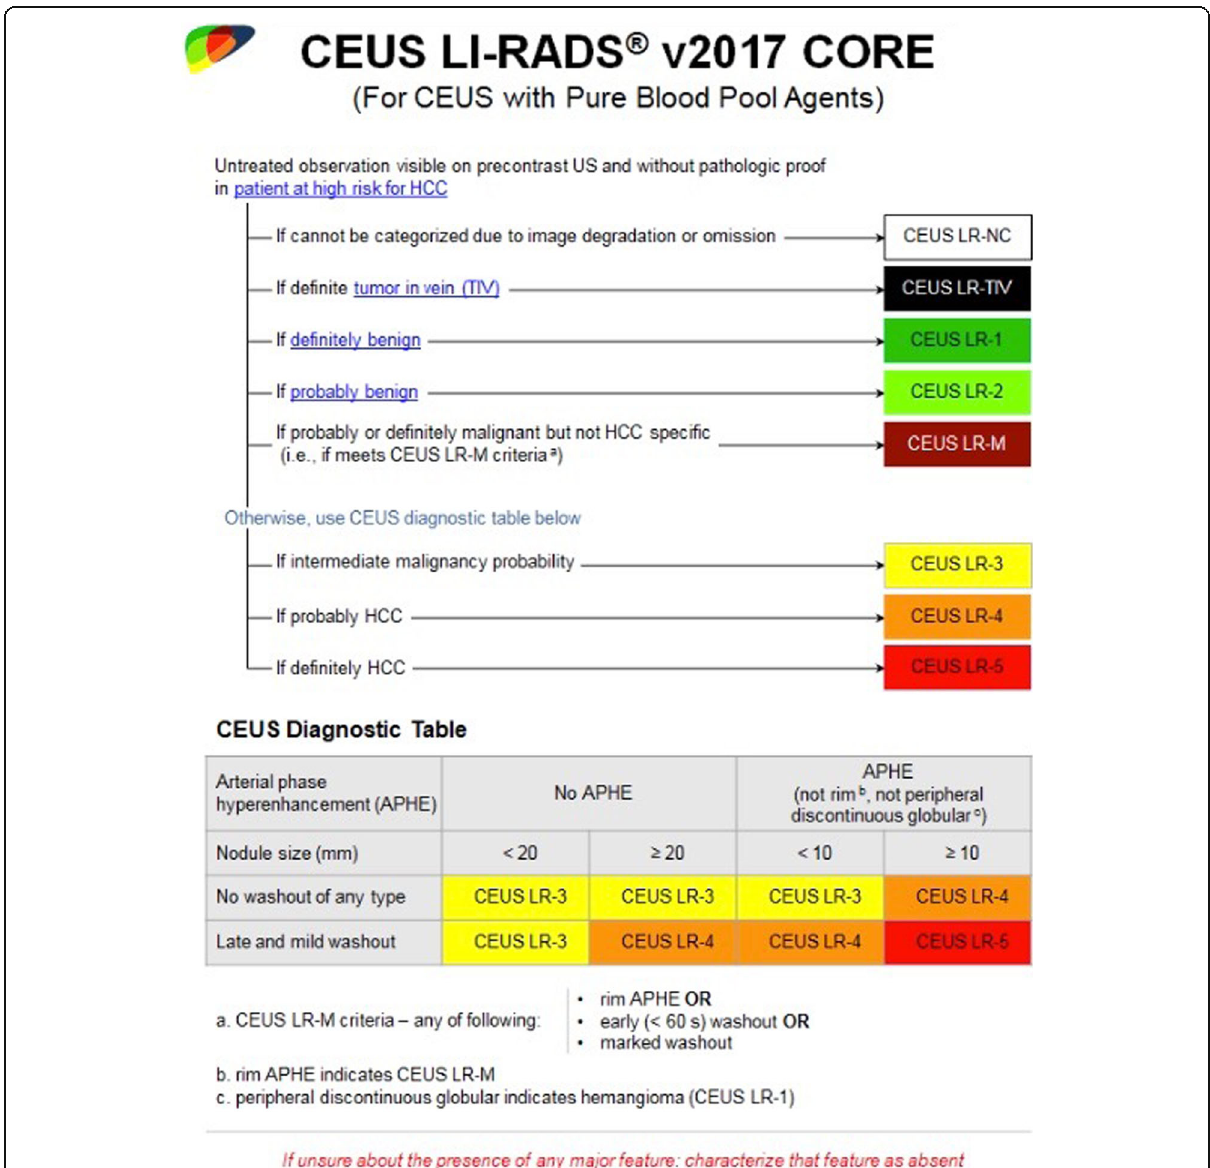
Fig. 1 ACR CEUS LI-RADS categorization and diagnostic